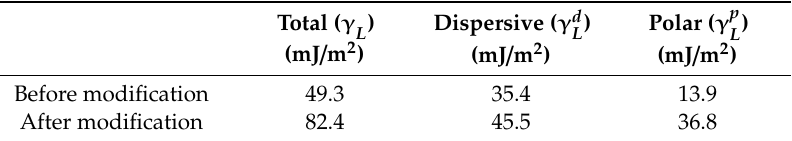
Table 3. Surface free energy of the substrate.